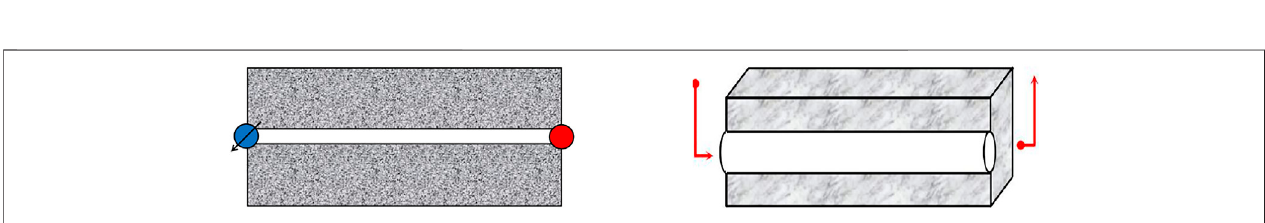
FIGURE 3 | Physical model of single pipe in one injection-production